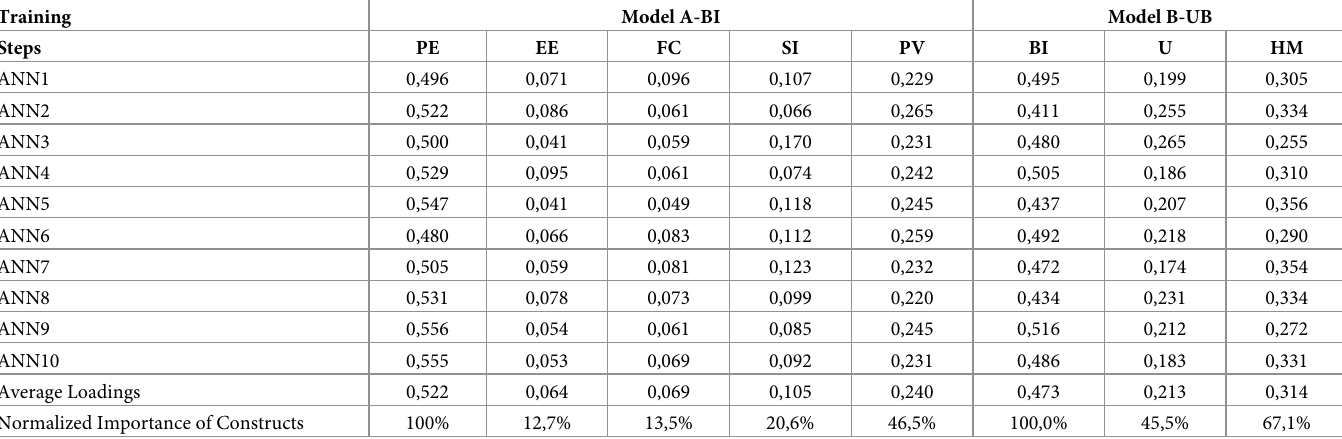
Table 5. The average loadings and normalized importance of